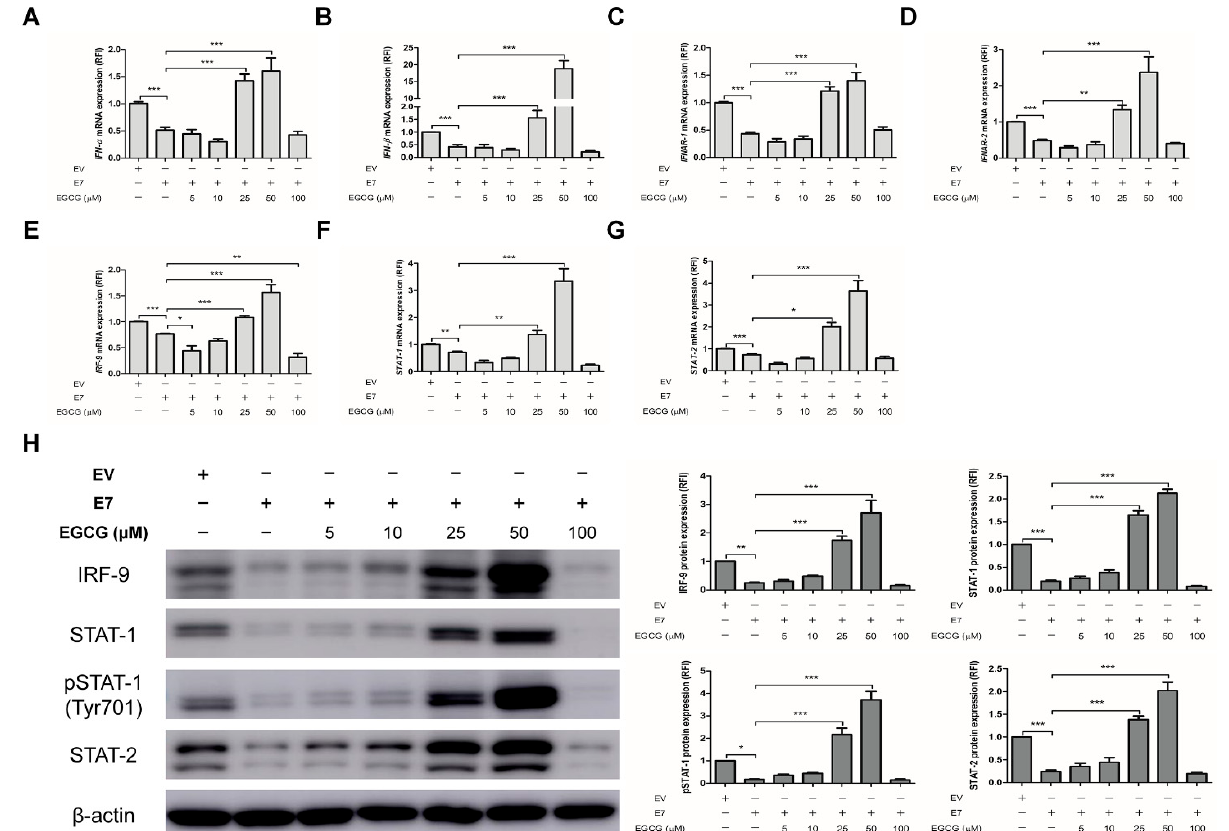
Figure 6. Effect of EGCG pretreatment on the expressions of type I interferon signaling pathway components in HPV-2 E7 transfected cells. HaCaT cells were treated with EGCG at the indicated concentrations for 2 h prior to E7 transfection. Following pretreatment with EGCG, the cells were transfected with empty vector or HPV-2 E7 . ( A - G ) Total RNA extracted from cells after 24 h transfection was subjected to the RT-qPCR for the mRNA levels of IFN- α ( A ), IFN- β ( B ), IFNAR-1 ( C ), IFNAR-2 ( D ), IRF-9 ( E ), STAT-1 ( F ), and STAT-2 ( G ). The relative mRNA levels were normalized against levels of GAPDH . ( H ) The protein levels of IRF-9, STAT-1, STAT-2, and tyrosine phosphorylation STAT-1 were measured using western blot analysis. The graph indicates quantitative representation of the protein levels of U-ISGF-3 components obtained from a densitometric analysis. β -actin served as a loading control for protein normalization. The results are expressed as the mean ± SEM of three independent experiments. * p < 0.05, ** p < 0.01, *** p < 0.001 compared with empty vector or E7 .